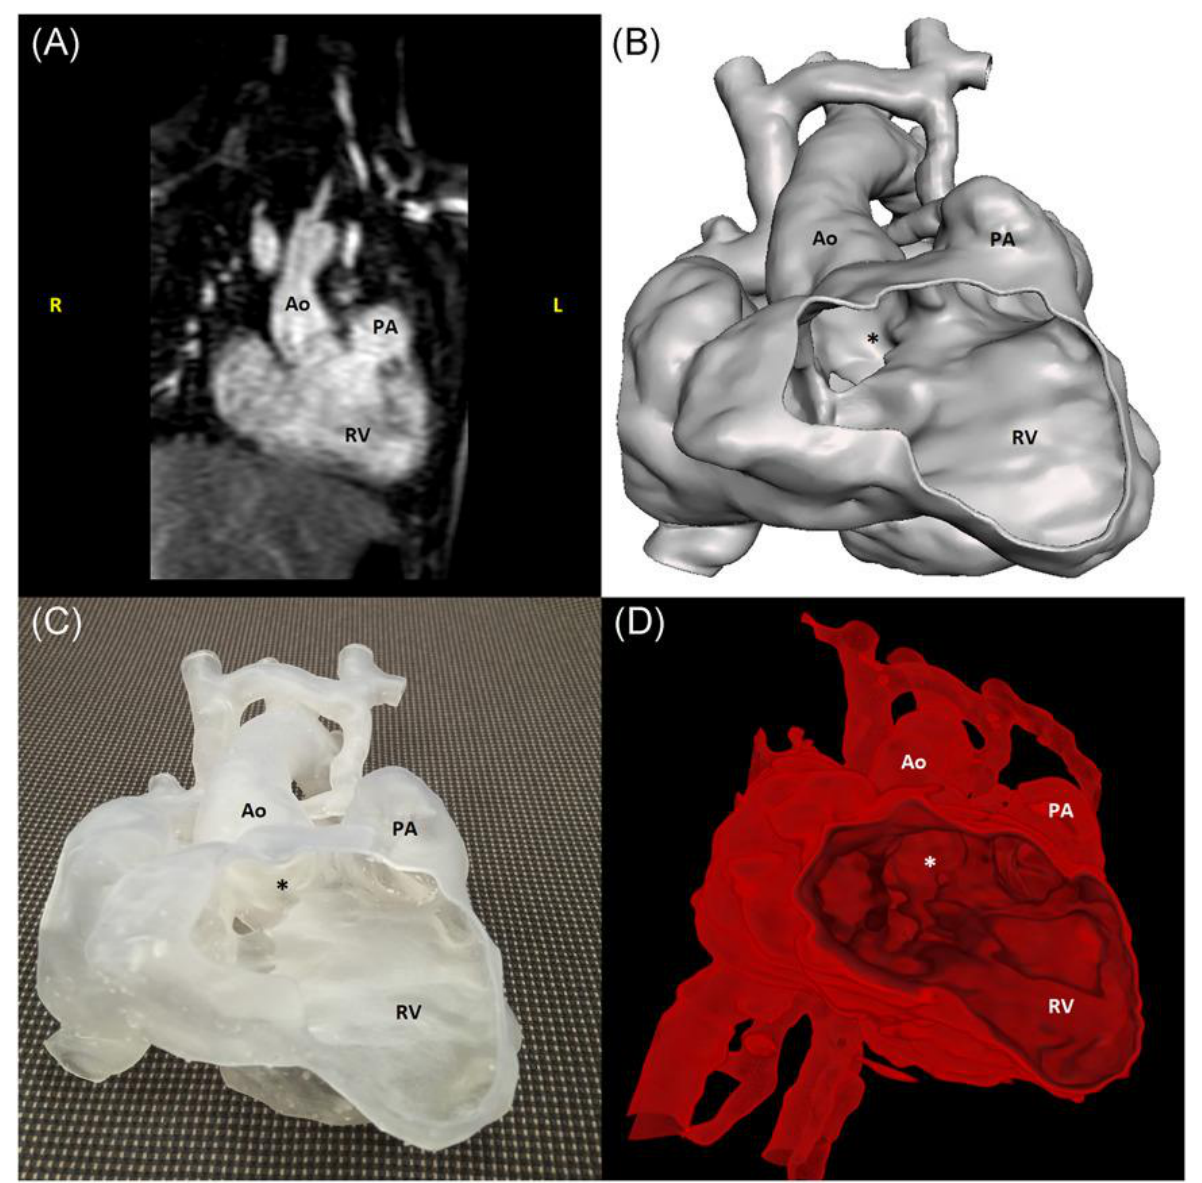
Figure 9. Images of a case with DORV with hyperplasia of the left ventricle and subaortic VSD: CMR scan ( A ), 3D PDF reconstruction ( B ), 3D-printed model ( C ), a screenshot of the DIVA software ( D ). * refers to ventricular septal defect. Ao — aorta; CMR — cardiac magnetic resonance; DORV — double outlet right ventricle; PA — pulmonary artery; RV — right ventricle; VSD — ventricular septal defect. DIVA refers to the user-friendly software for VR visualization. Reprinted with permission from Raimondil et al. [62].